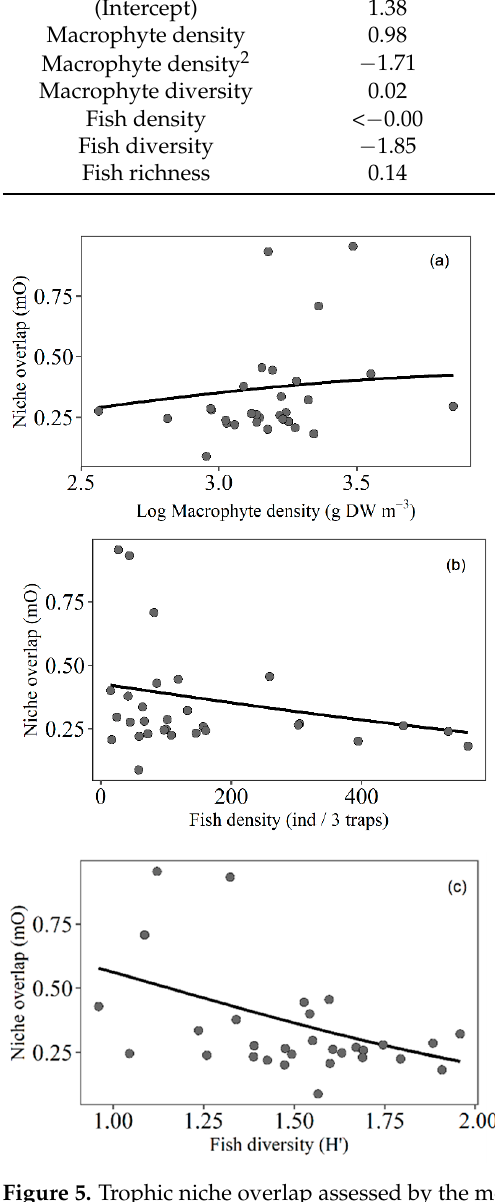
Figure 5. Trophic niche overlap assessed by the mean of Pianka’s Index (mO) related to macrophyte density ( a ), fish diversity ( b ), and fish density ( c )—the variables with significant effects in the performed beta regression. Note that log scale was used for macrophyte density.